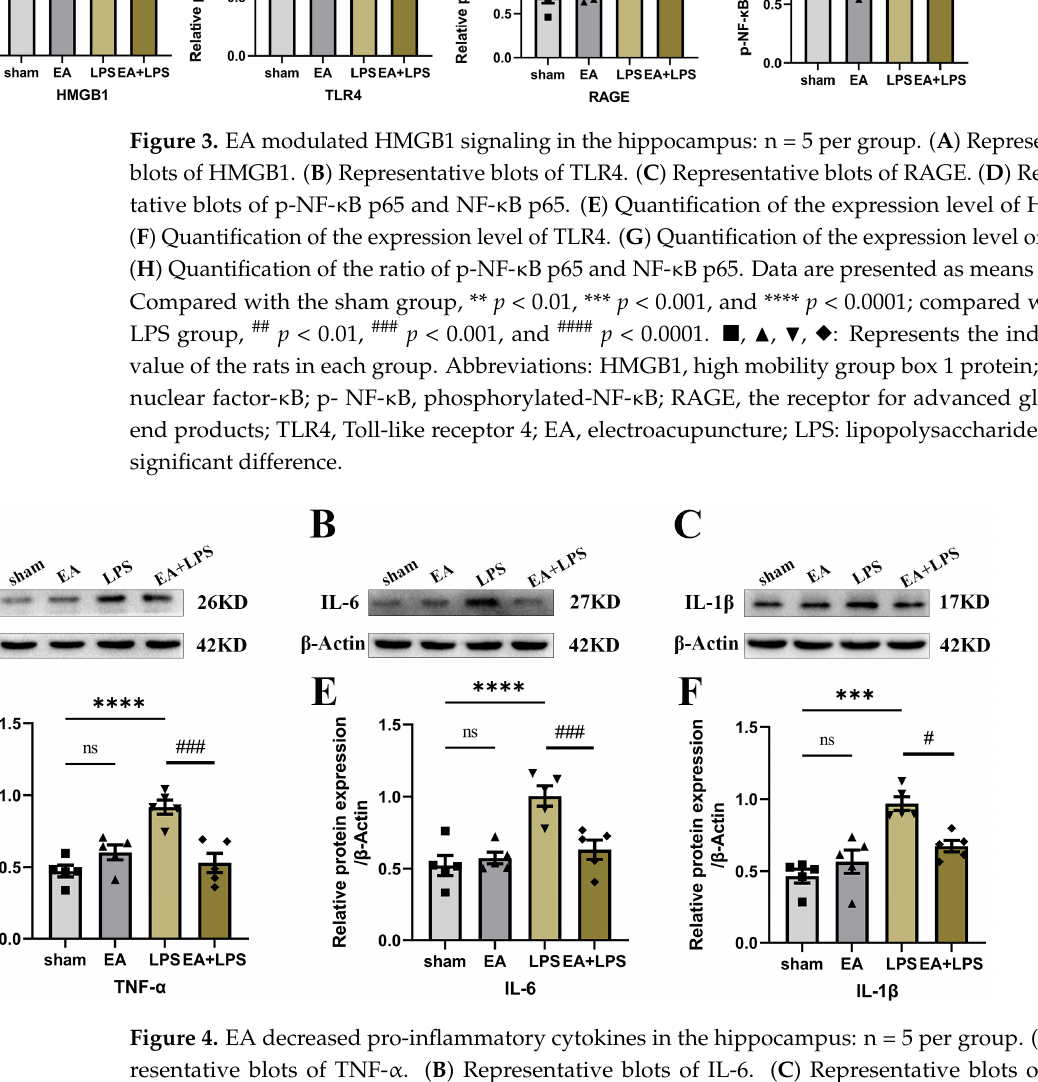
Figure 5. EA suppressed the expression level of Iba-1 and GFAP in the hippocampus: n = 5 per group. ( A ) Representative blots of Iba-1. ( B ) Representative blots of GFAP. ( C ) Quantification of the expression level of Iba-1. ( D ) Quantification of the expression level of GFAP. Data are presented as means ± SEM. Compared with the sham group, *** p < 0.001, **** p < 0.0001; compared with the LPS group, ## p < 0.01.  ,  ,  ,  : Represents the individual value of the rats in each group. Abbrevia- tions: GFAP, glial fibrillary acidic protein; Iba-1, ionized calcium-binding adapter molecule 1; EA, electroacupuncture; LPS, lipopolysaccharide; ns, no significant difference.